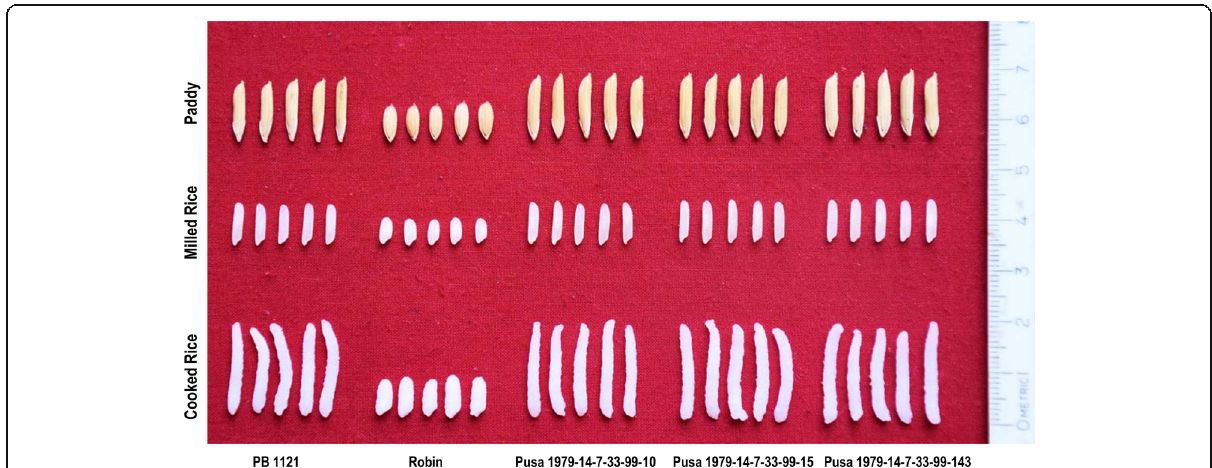
Fig. 9 Grain and cooking quality of selected PB 1121 HT-NILs and their parents, PB 1121 and Robin